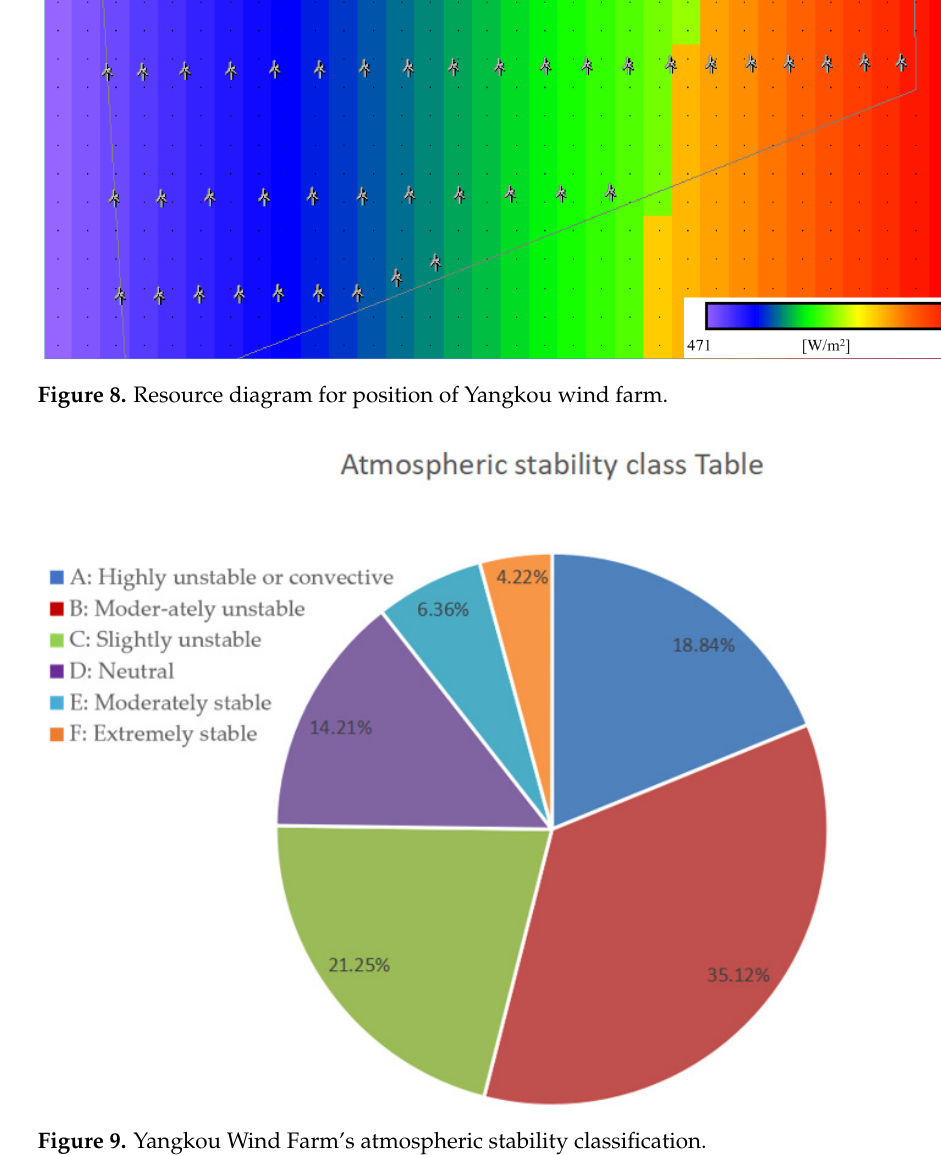
Figure 9. Yangkou Wind Farm’s atmospheric stability classification.